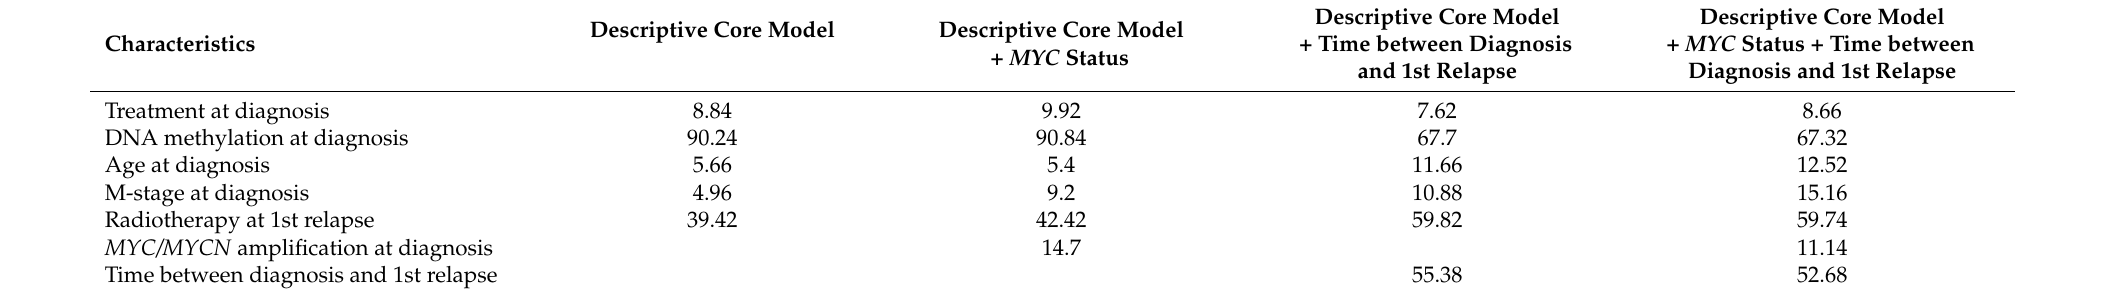
Table 3. Robustness analyses based on bootstrap